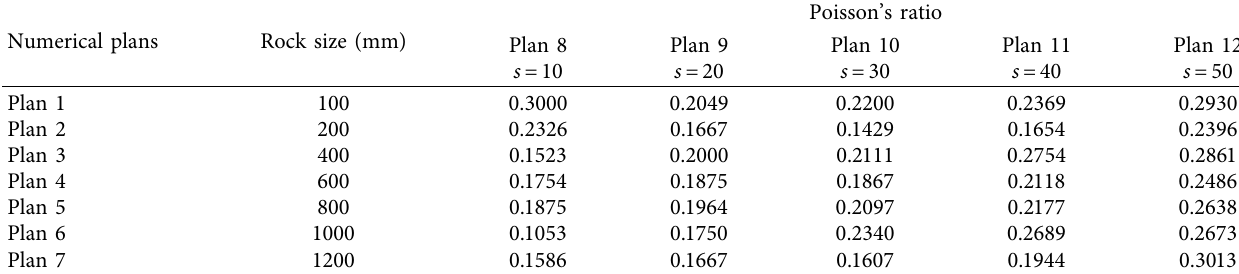
Table 3: Values of Poisson’s ratio.